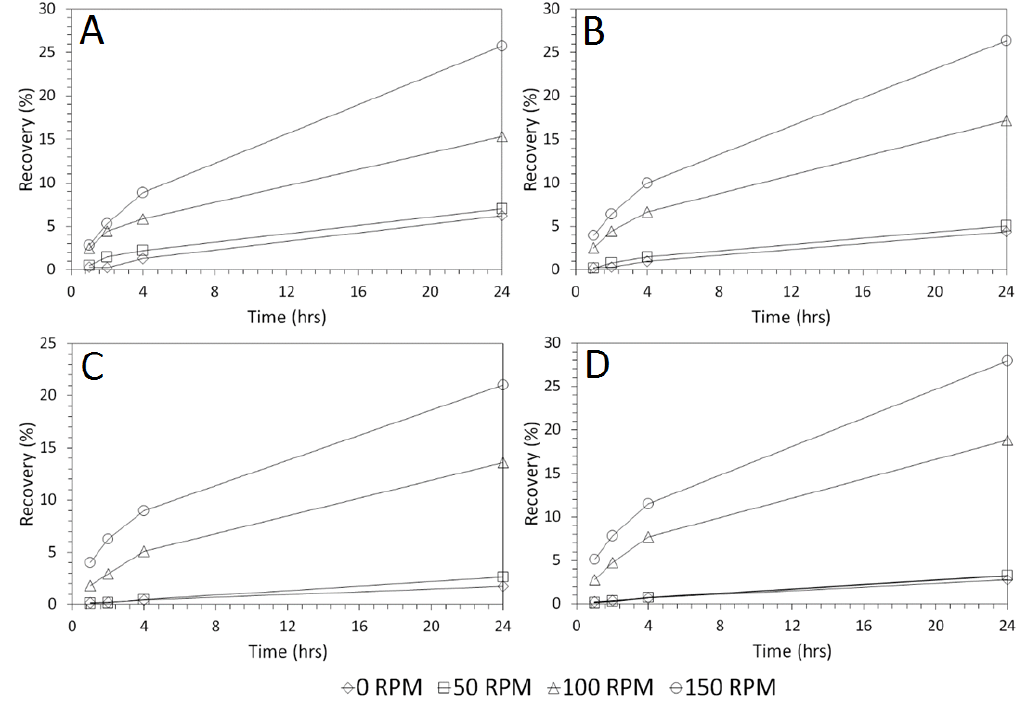
Figure 10. Cu recovery as a function of time for mixing speeds of 0, 50, 100, and 150 RPM using: H 2 SO 4 ( A ), HCl ( B ), C 6 H 8 O 7 ( C ) and CH 3 SO 3 H ( D ). The acid concentrations were 1 M and the lixiviant volumes were 200 mL.